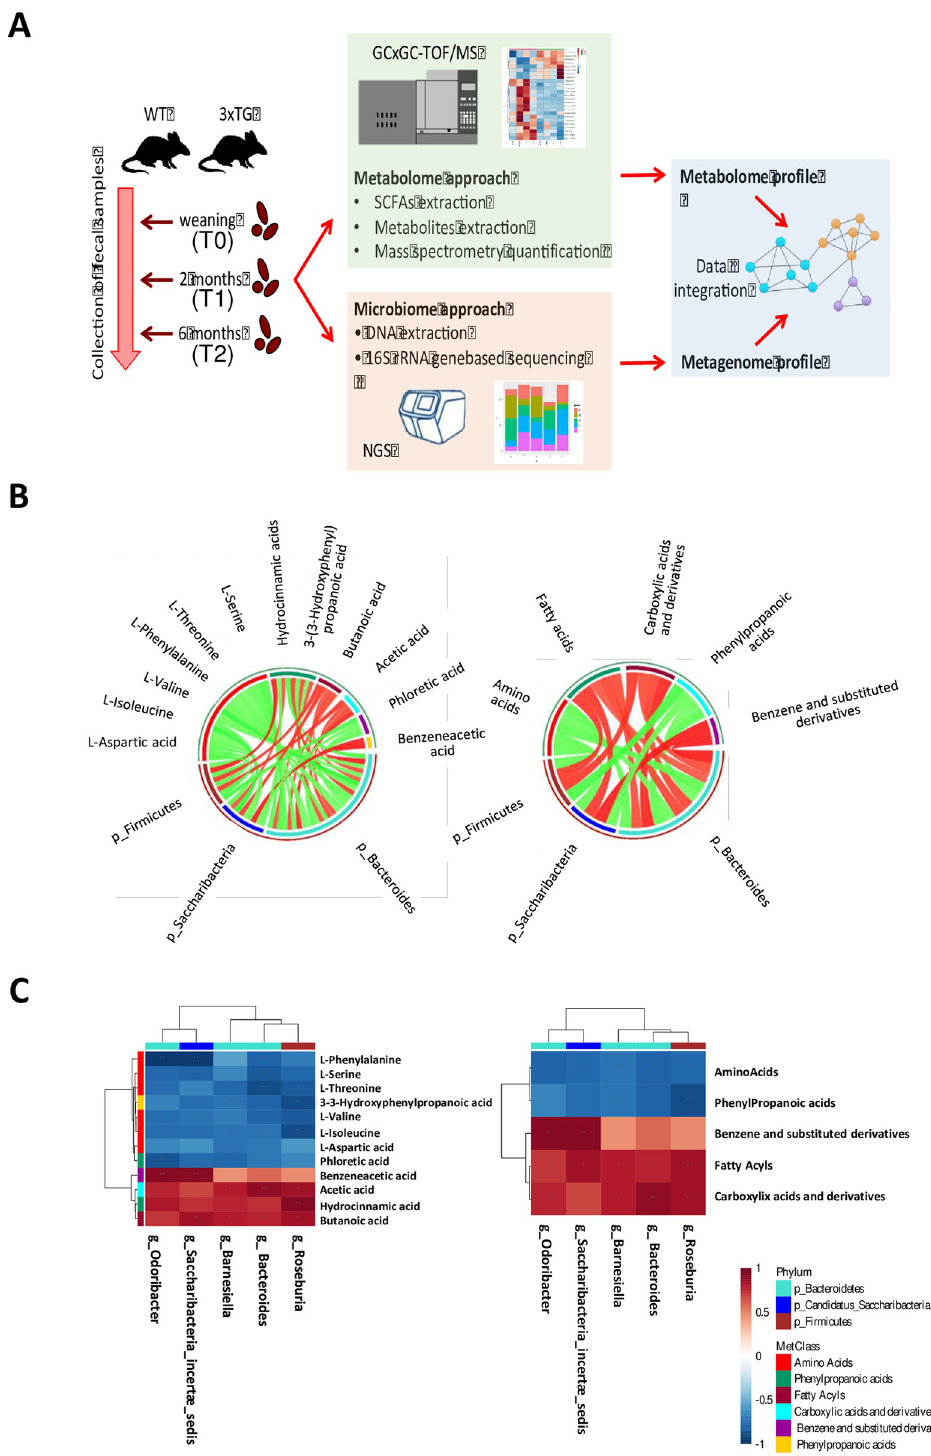
Fig 6. Metabologenomics. A) Workflow of the study. Fecal samples from WT and 3xTG mice at weaning, two and six months were collected and analyzed using metabolomic and metagenomic approaches. Metabolome and metagenome profiles were then analyzed and integrated to explore microbiome variations potentially associated with the progression of the disease. B) Circos plot of Spearman correlation between metabolite-phyla (left panel) and class- metabolites-phyla (right panel). A positive correlation is distinguished by red lines, while a negative correlation by